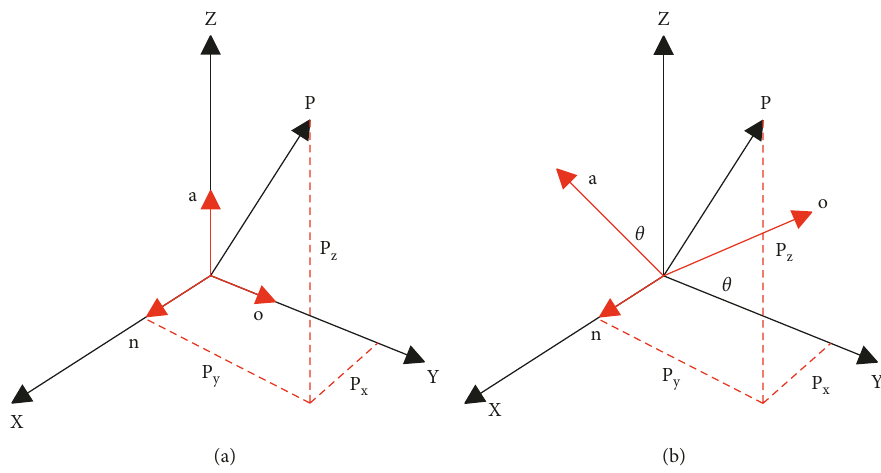
Figure 10: Rotation transformation diagram. (a) Before rotation. (b) After rotation.